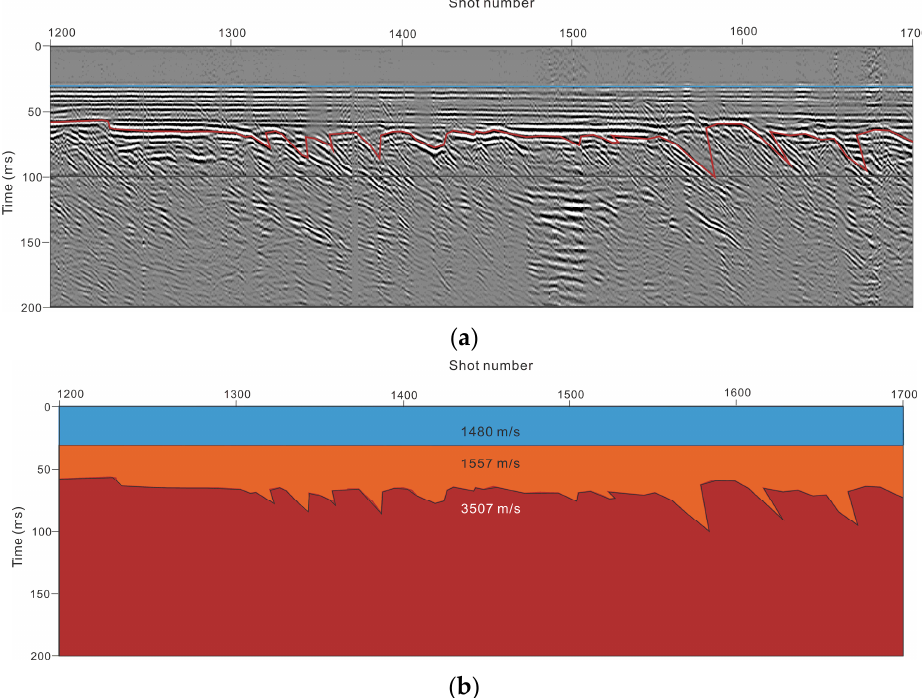
Figure 10. Processed reflection data from the single-channel seismic section image: ( a ) the interfaces identified by the auto-picker, where the blue line marks the seawater–shallow sediment interface and the red line marks the sedimentary deposits–acoustic basement interface, and ( b ) the interface from ( a ) overlain with velocity data.